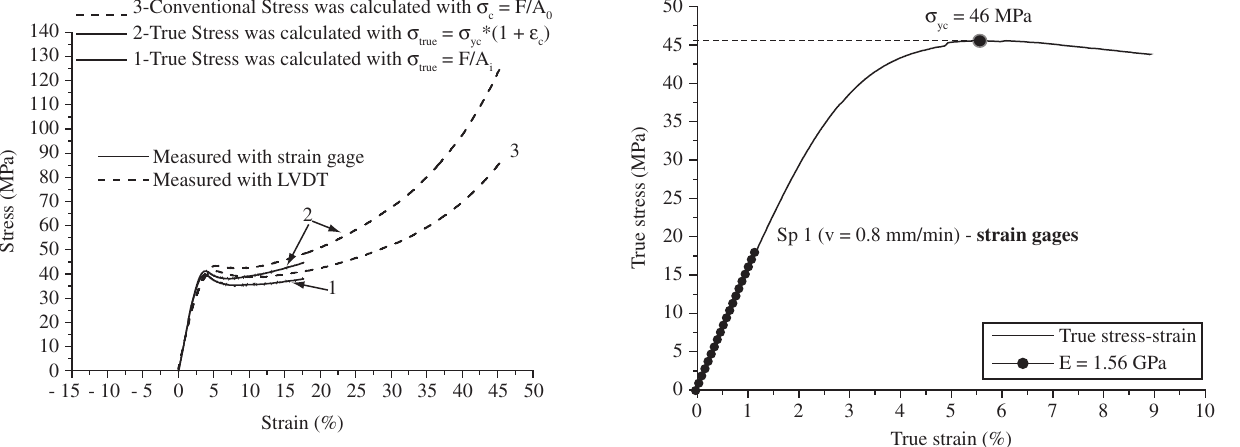
Figure 7. Conventional Stress vs. True Stress-strain curves: quasi - static, speed test = 0.8 mm/min.